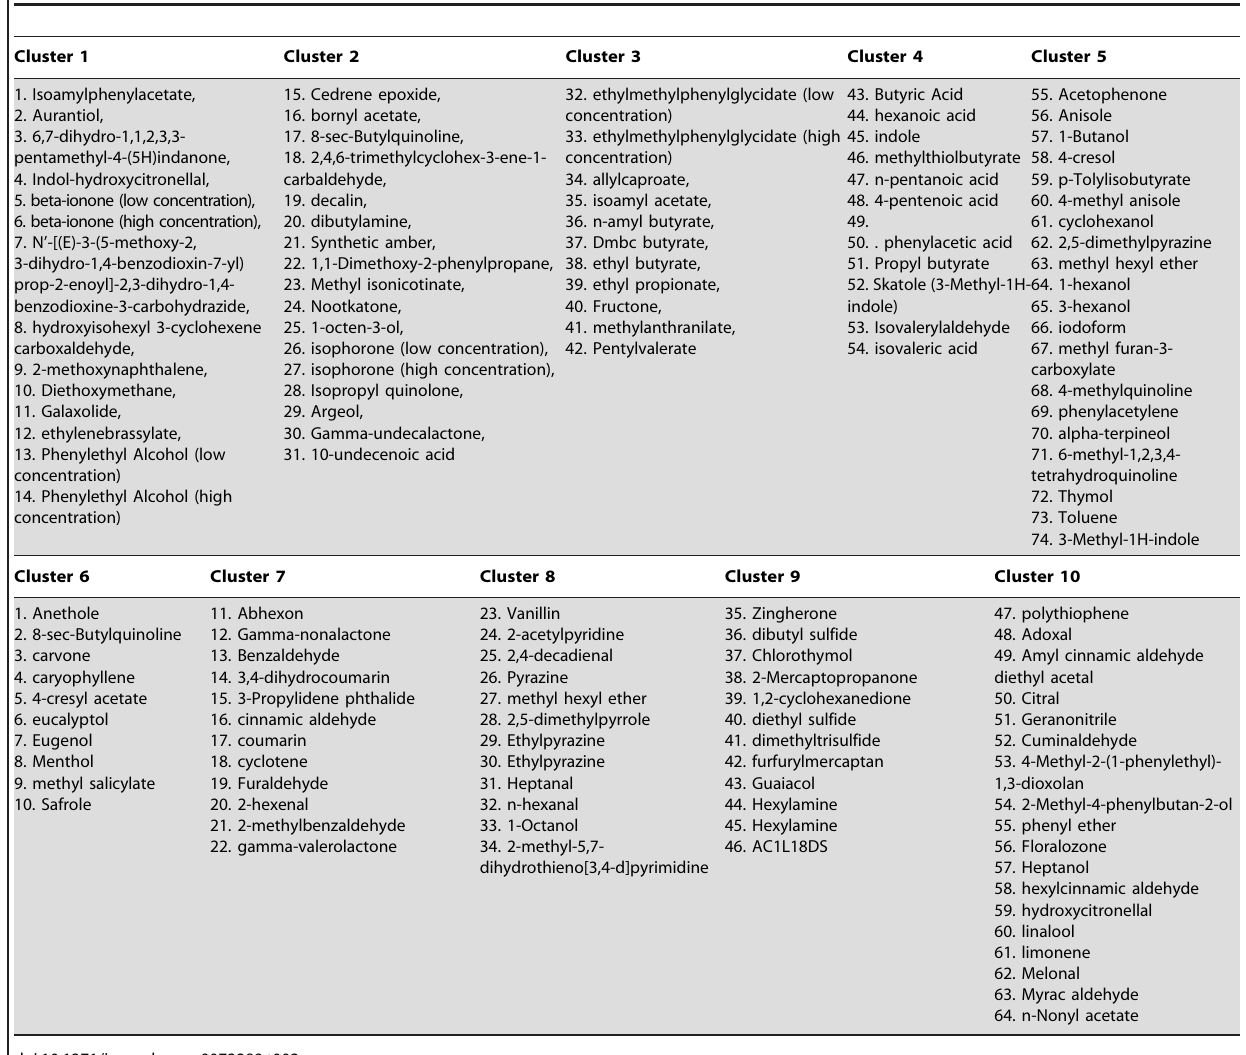
Table 2. List of compounds in every cluster identified from